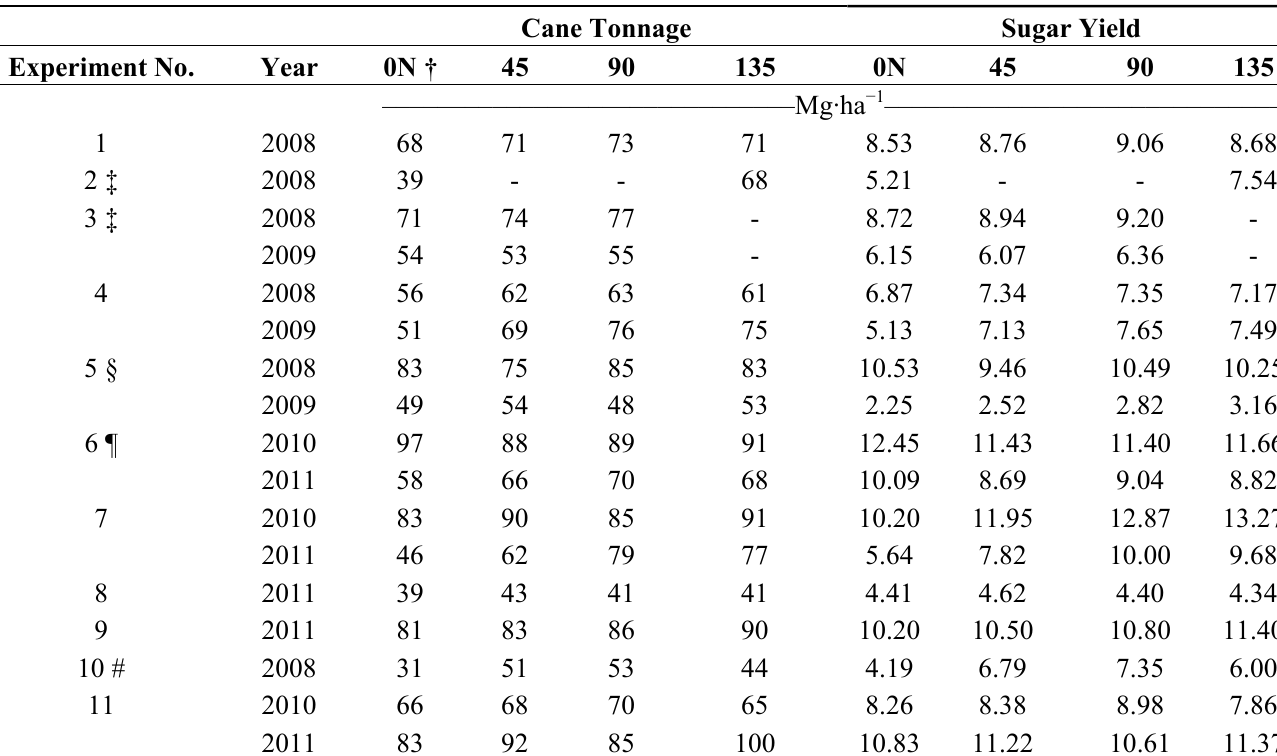
Table 5. Average sugarcane yield at different nitrogen fertilization rates achieved from 2008–2011 from St. Gabriel and Jeanerette, LA, USA. Cane Tonnage Sugar Yield Experiment